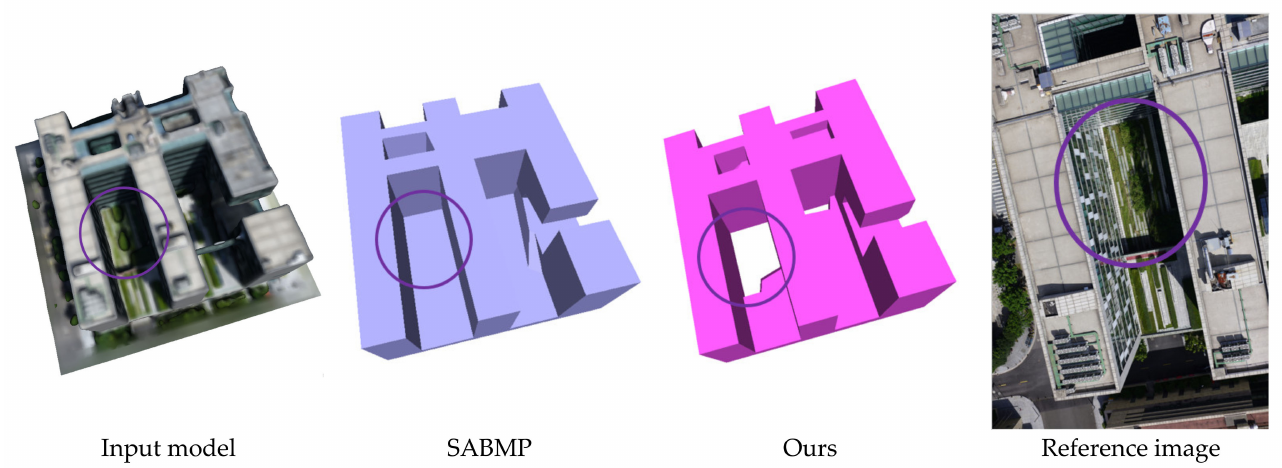
Figure 14. Comparison of ground discrimination results. The area of the purple circle should be the ground.